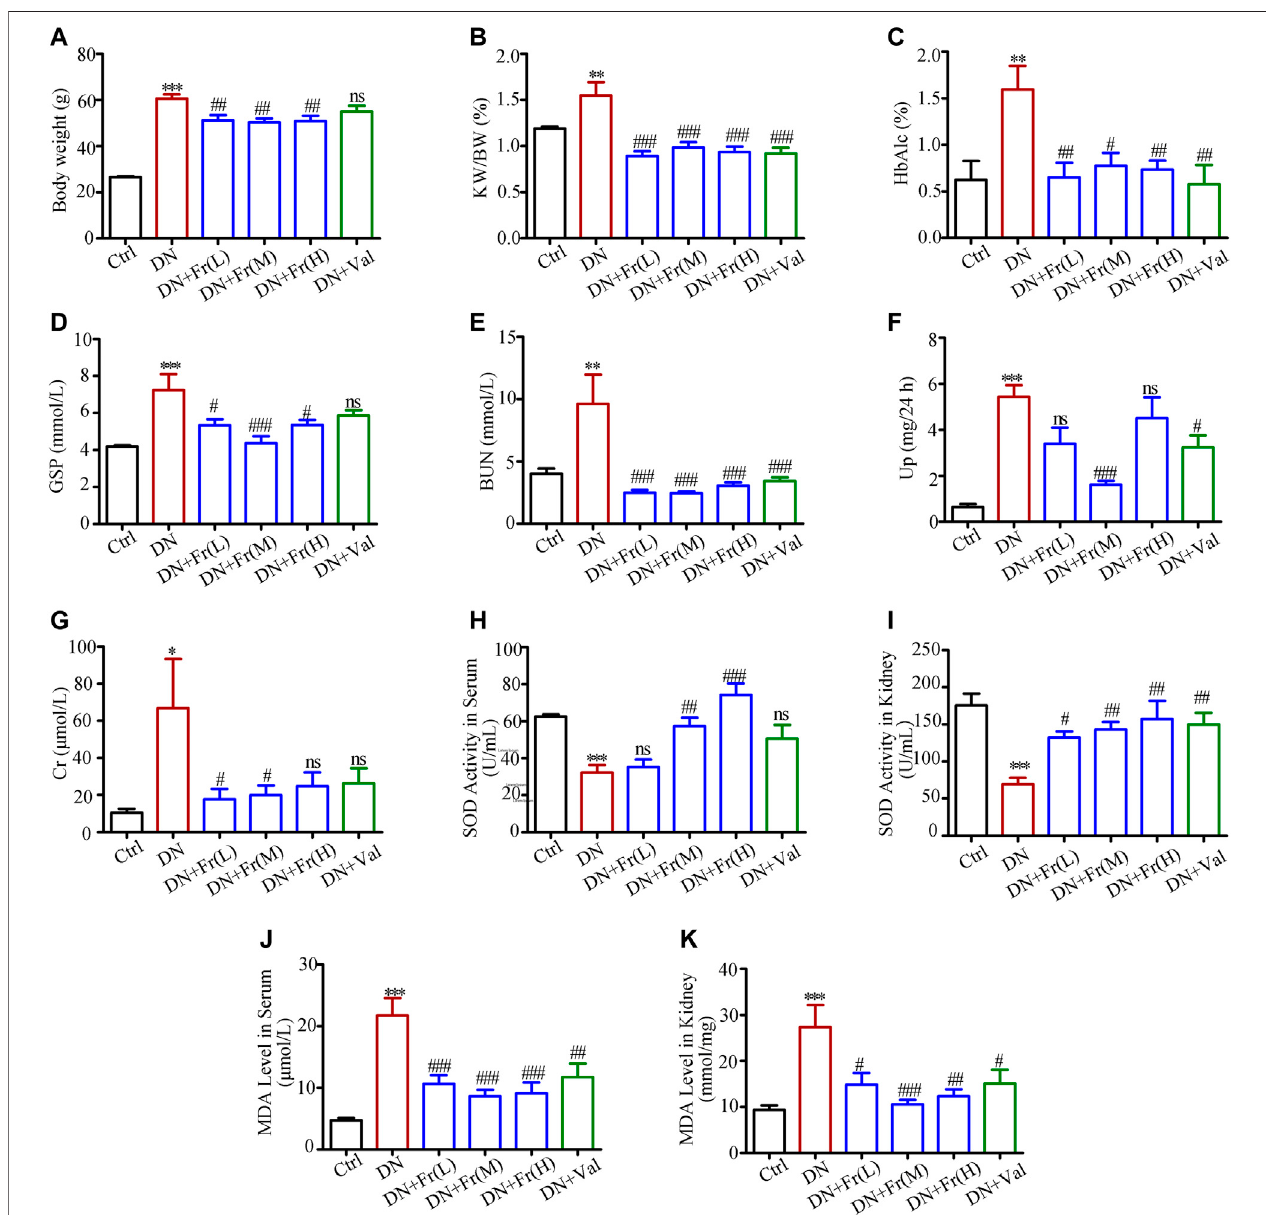
FIGURE 6 | Fr alleviated renal injury and improved renal function in db/db mice. (A) Body weight of experimental animals. (B) KW/BW, kidney weight/body weight ratio, n = 6 (C – K) HbA1c, GSP, BUN, Up, Cr, SOD and MDA of experimental mice. Data were expressed as±SEM, n = 6, Ctrl: control group; DN: diabetic nephropathy group; DN + Fr (L): Fr treatment group (low dose: 25 mg/kg); DN + Fr (M): Fr treatment group (medium dose: 50 mg/kg); DN + Fr (H): Fr treatment group (high dose: 100 mg/kg); DN + Val: valsartan treatment group (10 mg/kg). * p < 0.05, ** p < 0.01, *** p < 0.001 vs . Ctrl; ns, no signi fi cance; # p < 0.05, ## p < 0.01, ### p < 0.001 vs .